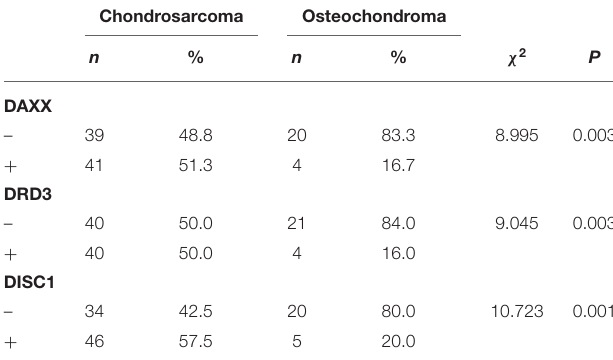
relationships of this expression to histological and clinical factors, TABLE 1 | DAXX, DRD3, and DISC1 expression in chondrosarcoma and osteochondroma.